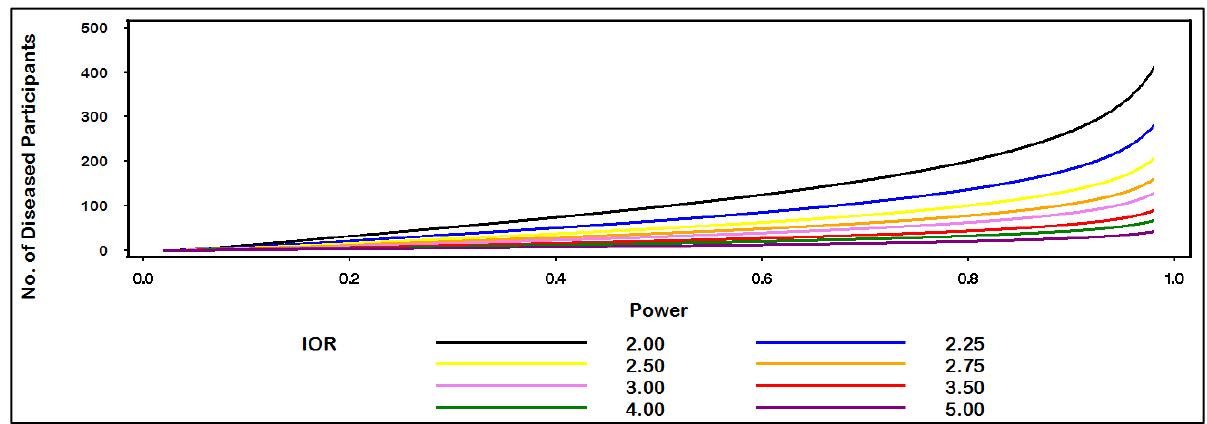
Figure 2. Sample size for IOR by